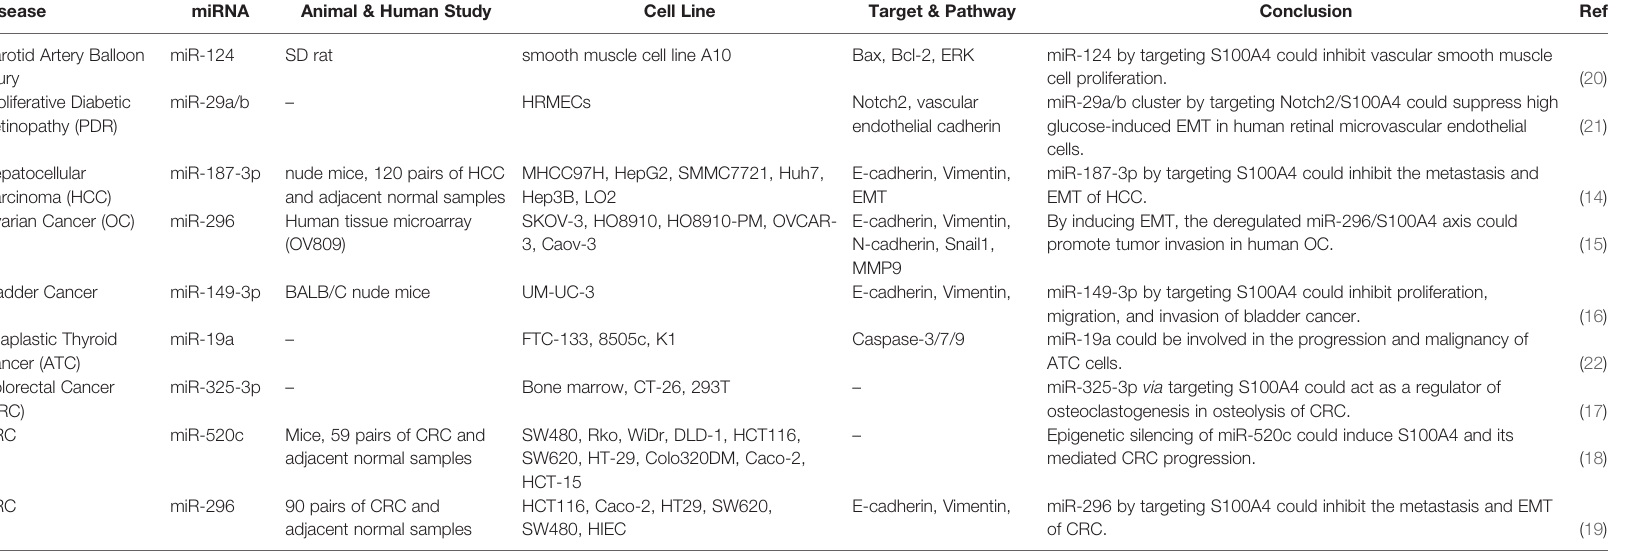
TABLE 3 | S100A4-interacting miRNAs.